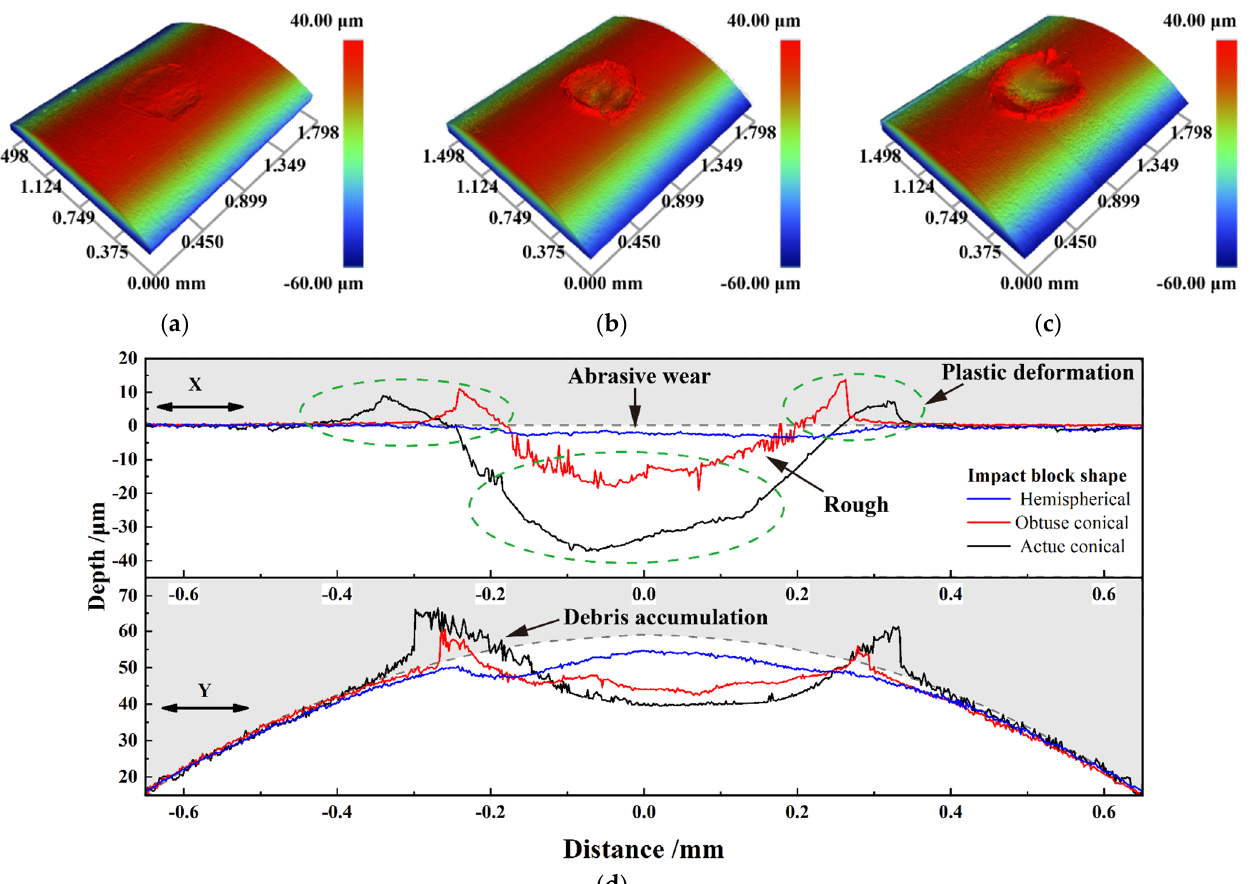
Figure 5. 3D topography and sectional profiles of wear scar after Zr − 4 alloy tube impacted 500,000 times: ( a ) hemispherical; ( b ) obtuse conical; ( c ) acute conical; ( d ) sectional profiles, the dotted line is the profile of the alloy tube before wear.